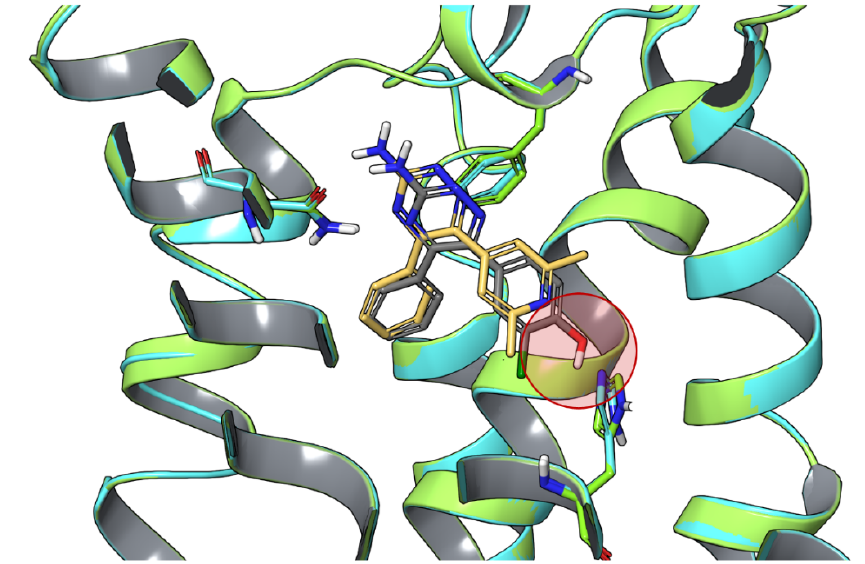
Figure 4. Superposition of the X-ray structures of A 2A AR bound to T4E (receptor in light green and ligand in gray; PDB ID: 3UZC [17]) and T4G (receptor in cyan and ligand in orange; PDB ID: 3UZA [17]). The area of “unhappy” water molecules favorably displaced by the hydroxyl moiety of T4E is highlighted by a red circle.